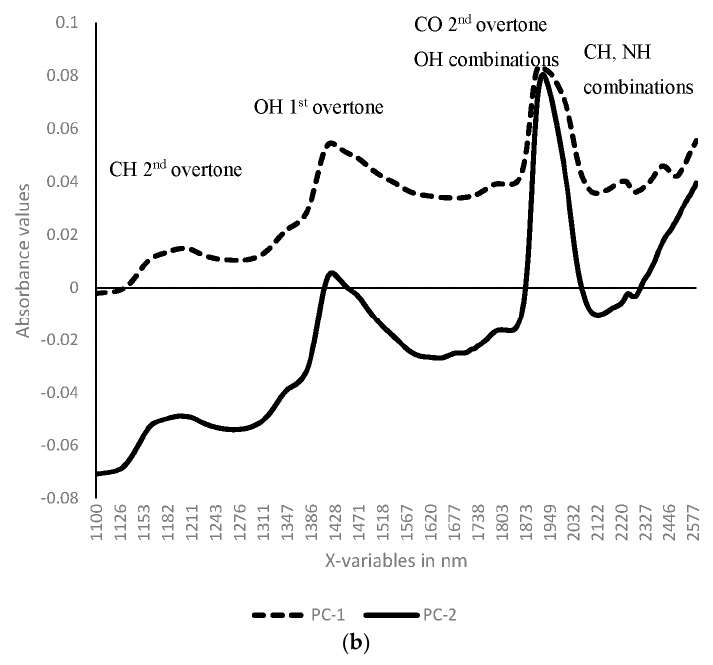
Figure 2. ( a ) Principal component analysis (PCA) scores plot of raw NIR spectral data from maize kernels in stage categories; ( b ) Loadings plots for PCA plots of maize kernels in stage categories. Data pre-processing using 1d-SG analysis (using five smoothing points), followed by MSC